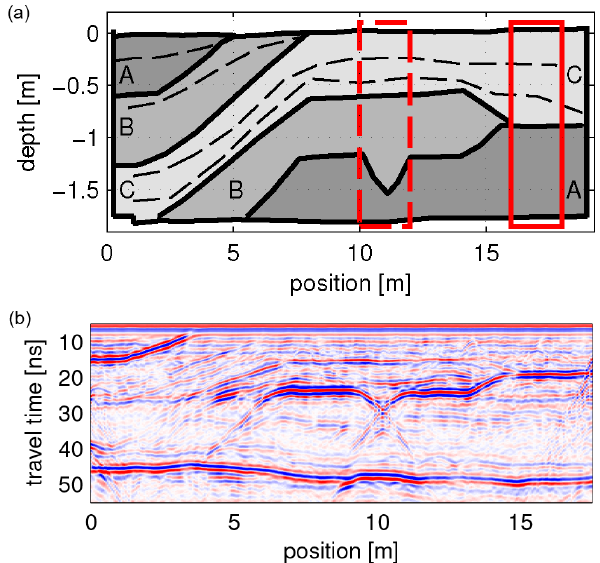
Figure 1. (a) Overview of the subsurface architecture of the AS- SESS test site. Solid black lines indicate the layer boundaries be- tween the three different kinds of sand (A, B and C). Dashed black lines indicate known compaction layers, which are an artifact of the building process. The solid (dashed) red rectangle denotes the re- gion for the water content measurements illustrated in Fig. 8a and b. (b) Exemplary radargram acquired by an IDS 400MHz antenna. A linearly increasing gain function has been applied for increasing the visibility of lower layer